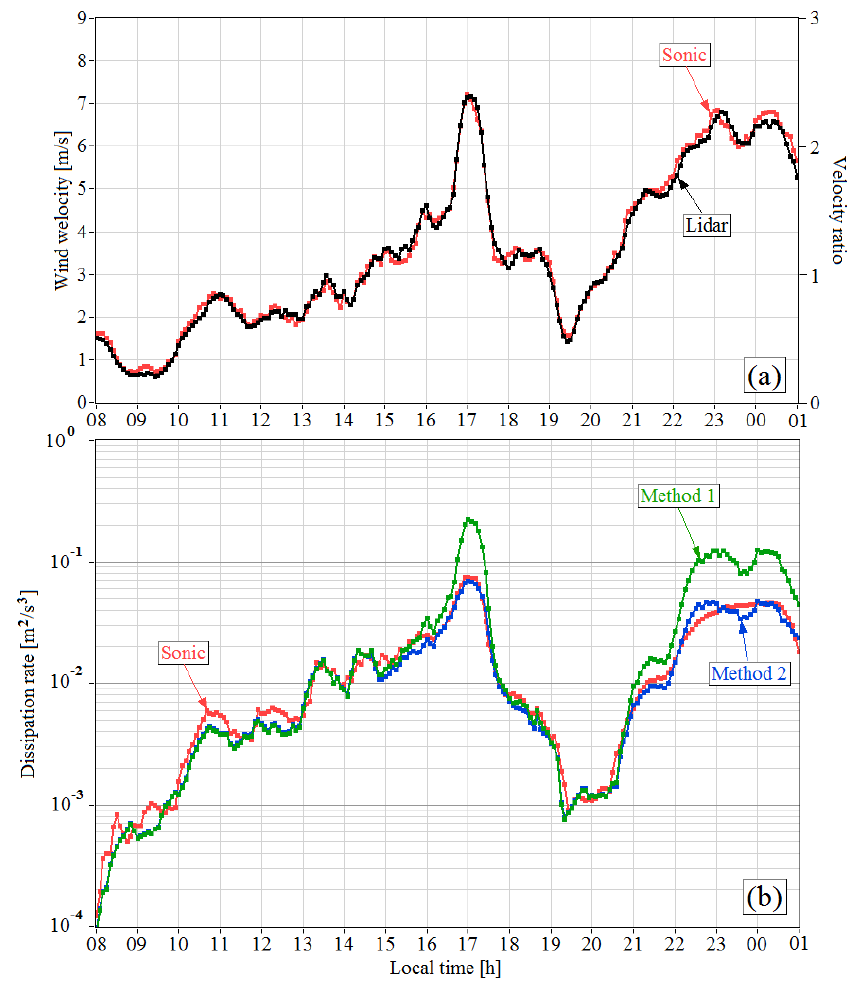
Figure 8. Time series of the mean wind velocity and the velocity ratio µ ( a ), the turbulence energy dissipation rate ( b ) at a height of 42 m as obtained from measurements by the Stream Line lidar (black, green and blue curves) and the sonic anemometer (red curves). The measurements were carried out at the BEO starting from 08:00 LT on 13 May of 2020. For estimation of the dissipation rate, Method 1 (green curve) and Method 2 (blue curve) were used.